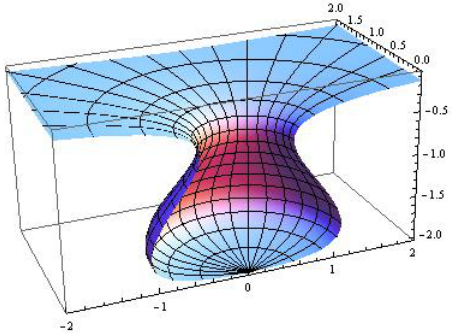
Figure 2 . The schematic cross-section of a black hole, including a star under the neck. The space outside the \bag" is asymptotically Schwarzschild. While r increases as we go deeper down in the vacuum, it decreases inside the star to zero at the origin. The notion of proper distance is not properly represented in the